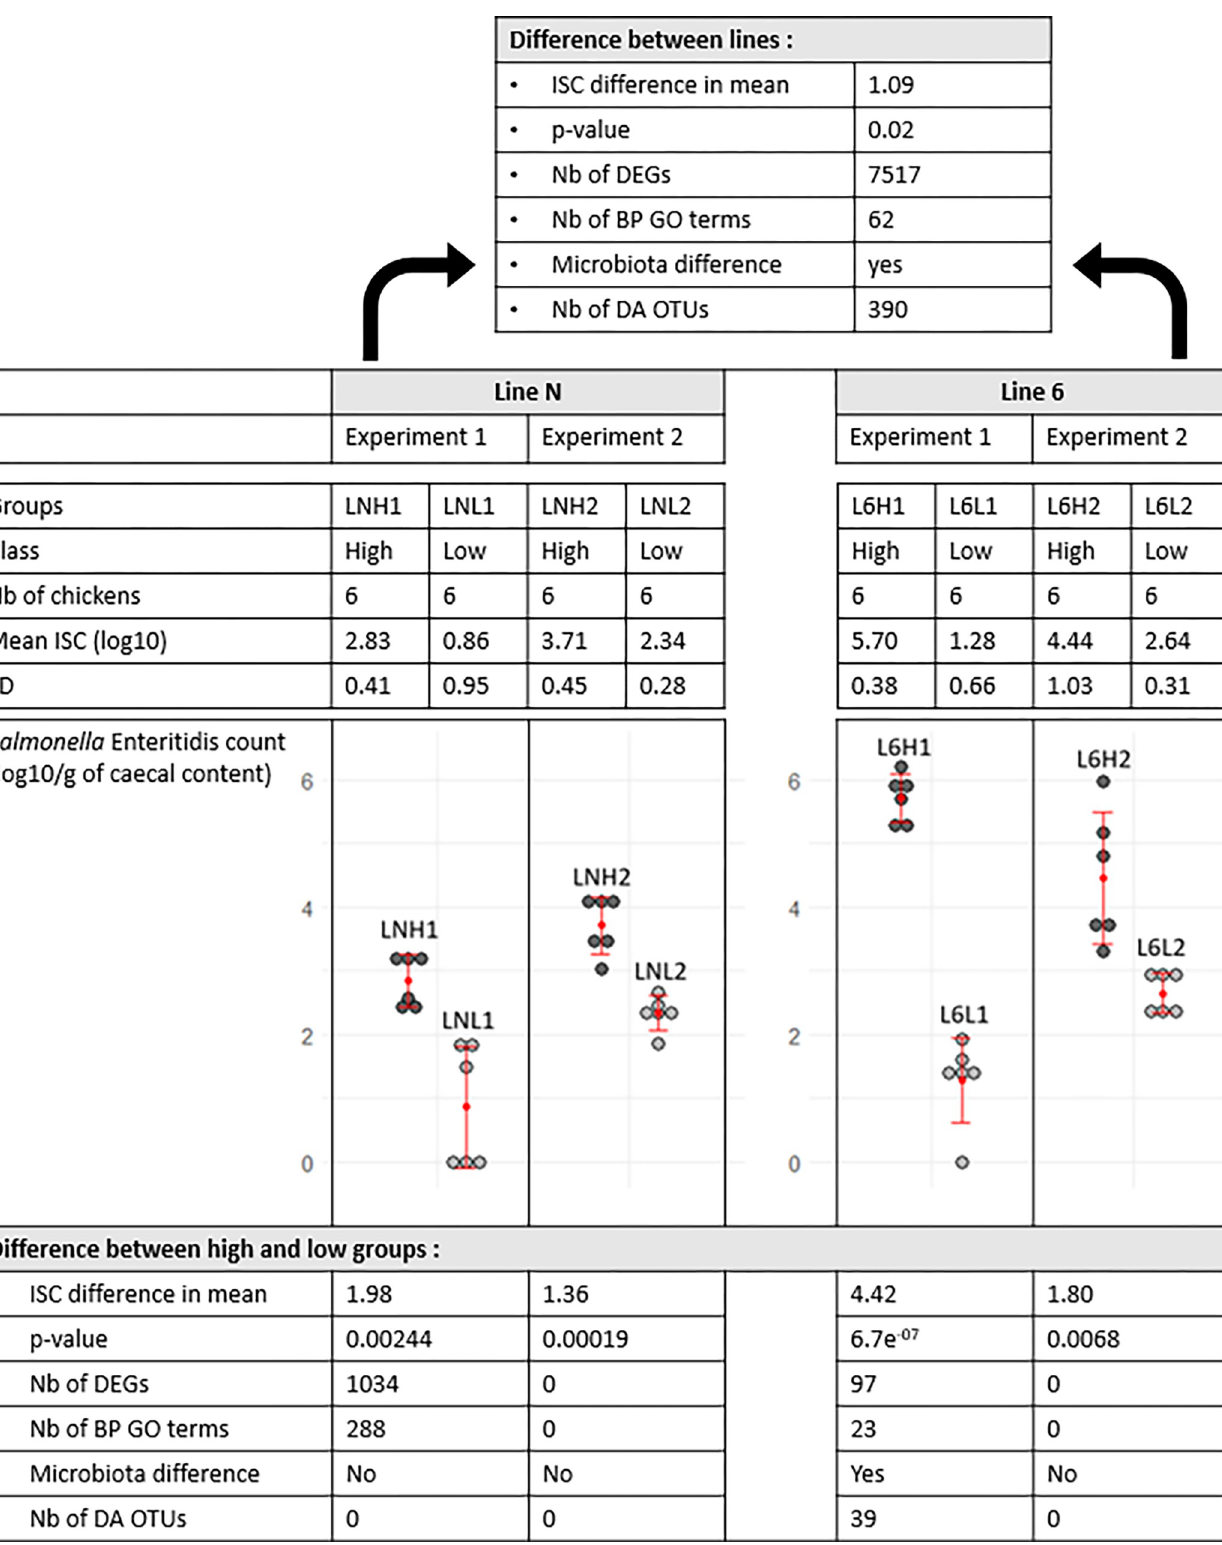
Fig 1. Summary of the results of comparisons between lines and between low and high carrier classes within lines according to the experiment. Mean (red points) and standard deviation (SD; red bars) of the Salmonella Enteritidis abundance at 12 dpi in caecal contents (log10/g of caceal contents) of chicken